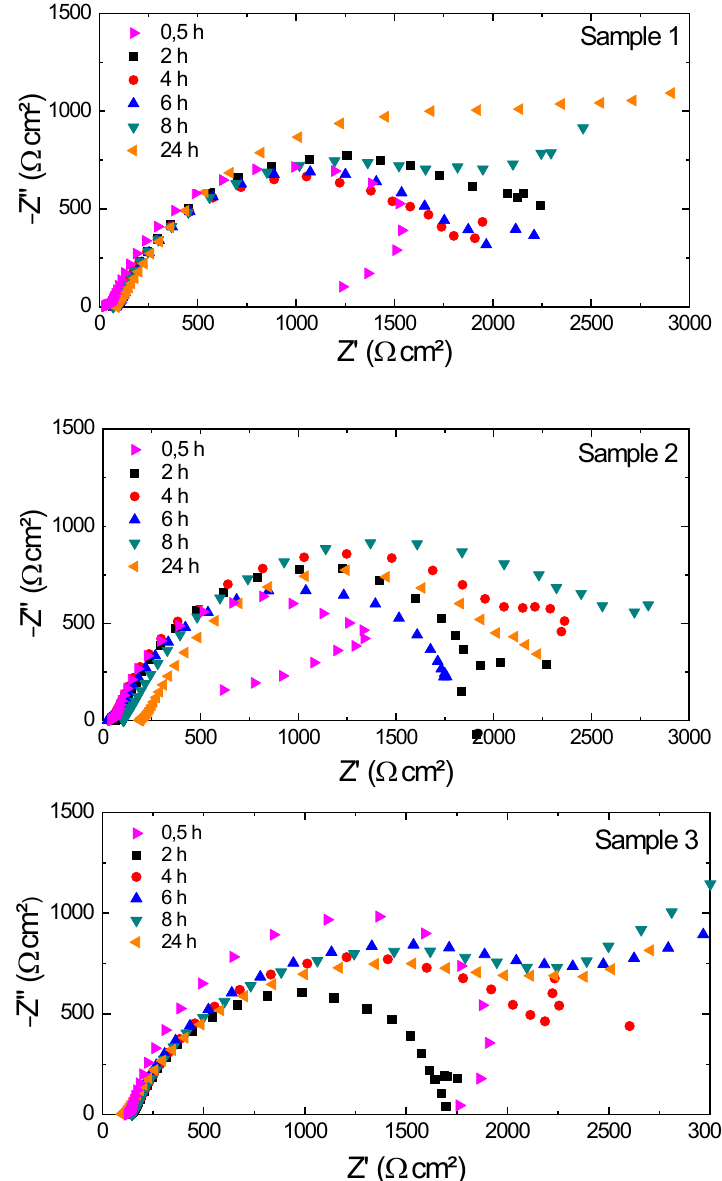
Figure 11. Nyquist diagrams for the three samples of 1020 carbon steel immersed in NaCl.